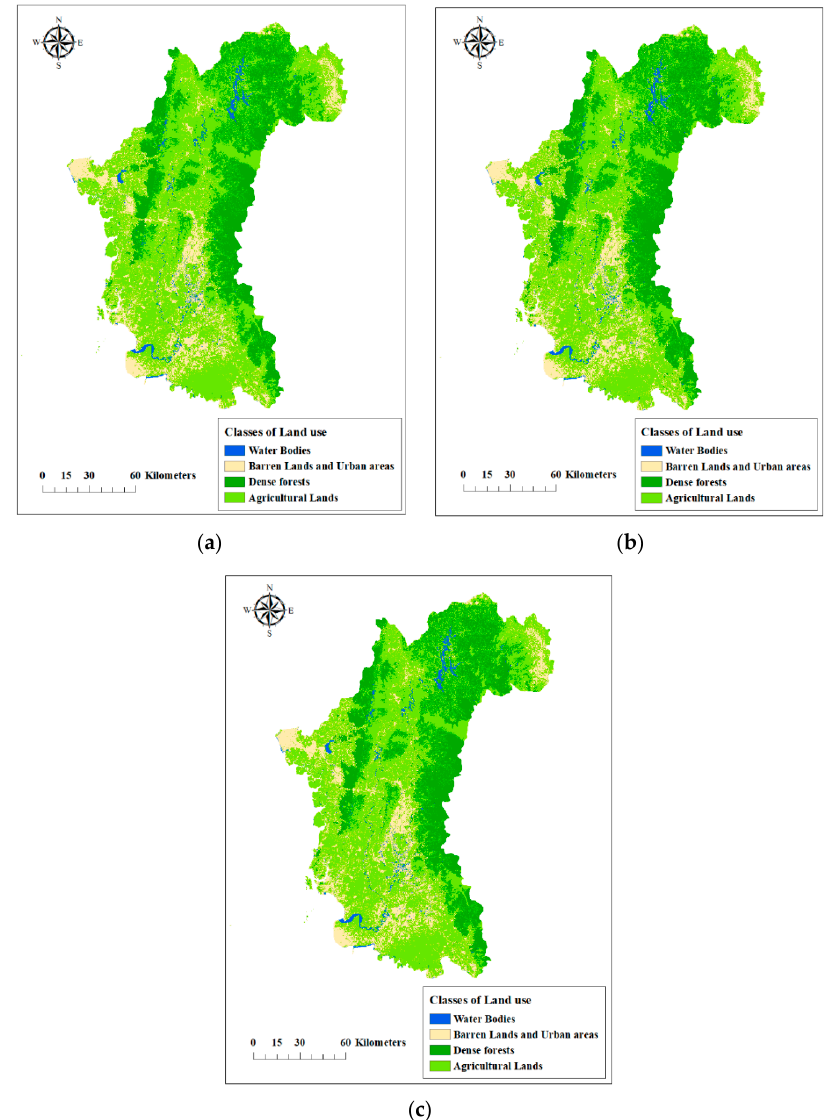
Figure 9. Predicted LULC of Perak River basin for: ( a ) year 2030; ( b ) year 2040; and ( c ) year 2050.